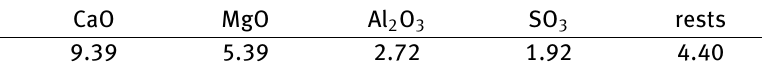
Table 1: Chemical characteristics of the tailings Compound SiO 2 Fe 2 O 3 CaO MgO Al 2 O 3 SO 3